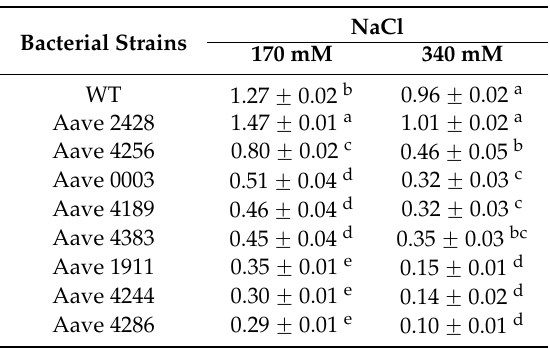
Table 5. Effect of NaCl on the growth of virulence-related mutants of biofilm-defective strain A1 in LB